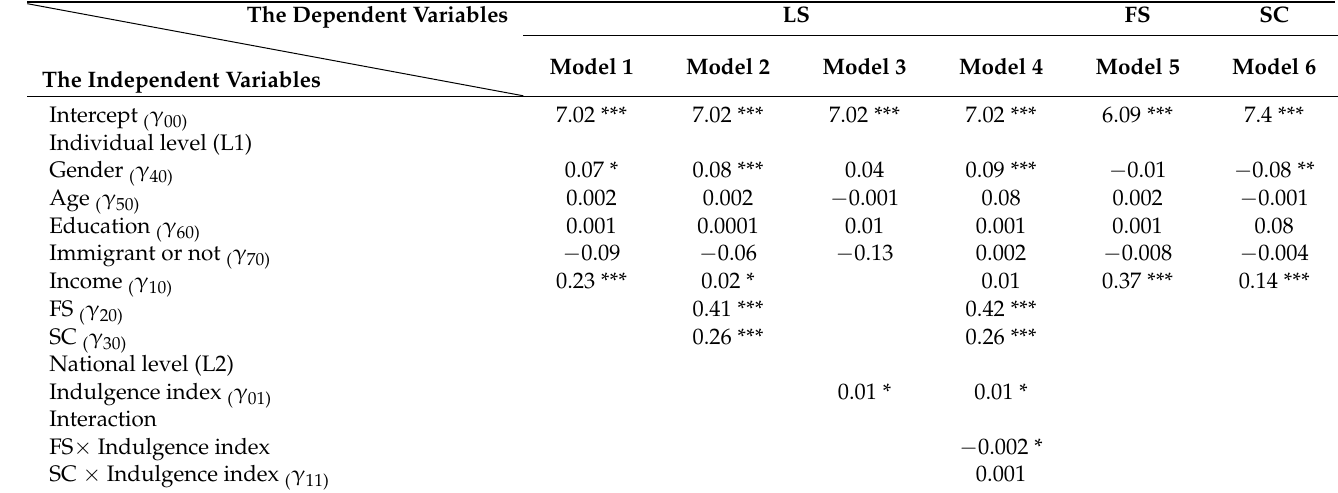
Table 2. Testing the moderated mediation effects for Life Satisfaction in study 1 ( N =